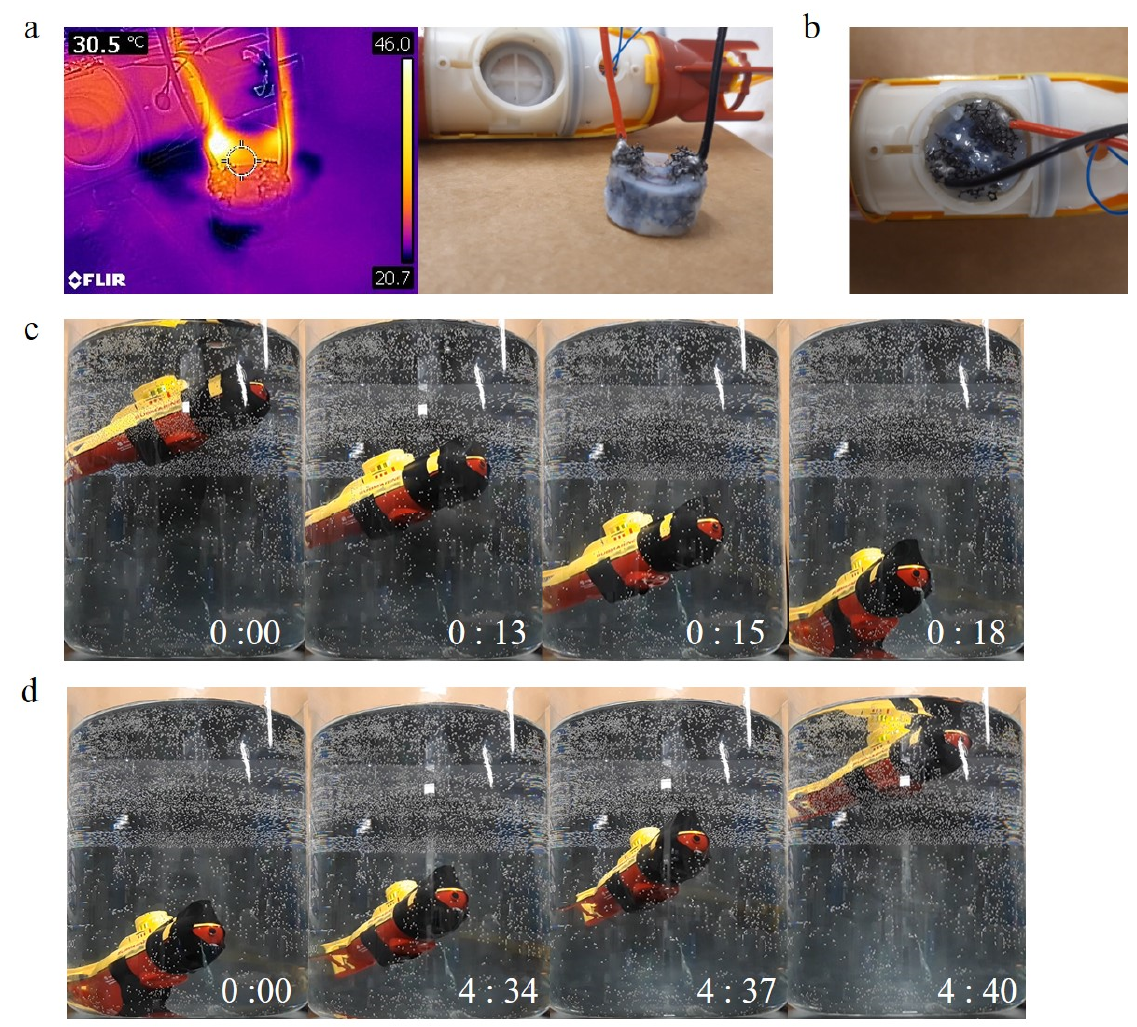
Figure 5. Remotely controllable miniature submarine with adjustable buoyancy using an electrically heated PNIPAM/carbon hydrogel composite. ( a ) Thermal image (left image) of PNIPAM/carbon device when supplied with 4.09 V for five minutes. The right image shows the PNIPAM/carbon gel with electrical connections and before insertion in the submarine. ( b ) PNIPAM/carbon buoyancy control device placed in the cavity at the underside of the submarine. Note that the red protective shell of the submarine has been removed to show the hydrogel composite and connecting wires. ( c ) Optical images of the submarine in water during sinking. ( d ) Images of submarine during floating. A pre-heating period of 4 min and 34 s was required to initiate floating which was then completed within 6 s.